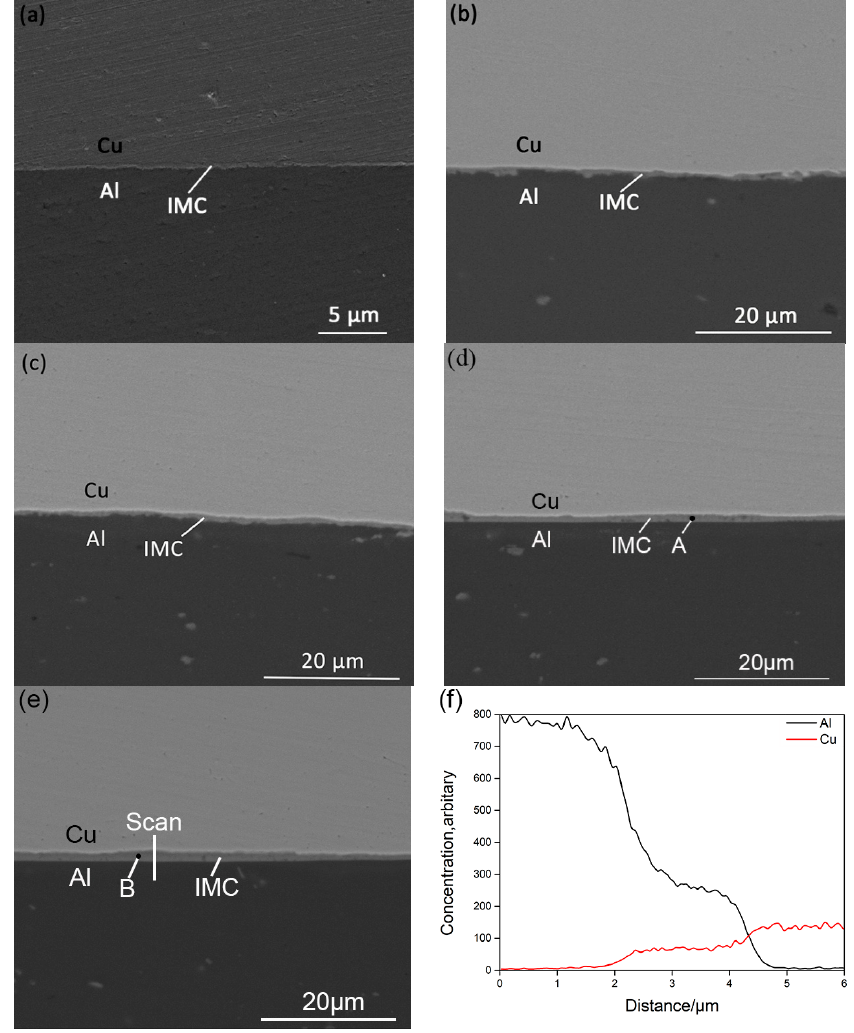
Figure 2. Scanning electron microscopy observations of the welding interface for the amplitude of 22.5 μ m at welding times of ( a ) 0.6 s, ( b ) 0.7 s, ( c ) 0.8 s, ( d ) 0.9 s, ( e ) 1.0 s and ( f ) energy dispersive